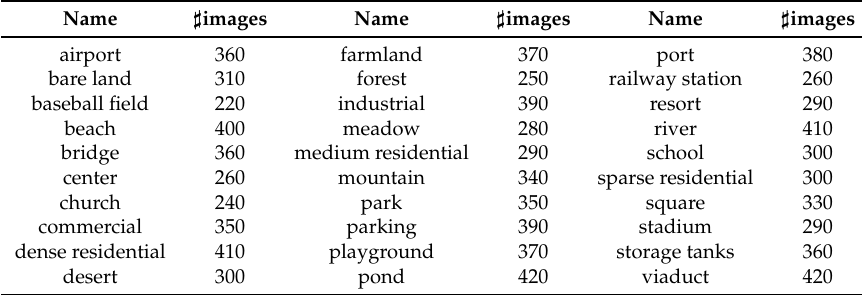
Table 1. Scene classes and the number of images per class in the Aerial Image Dataset (AID)